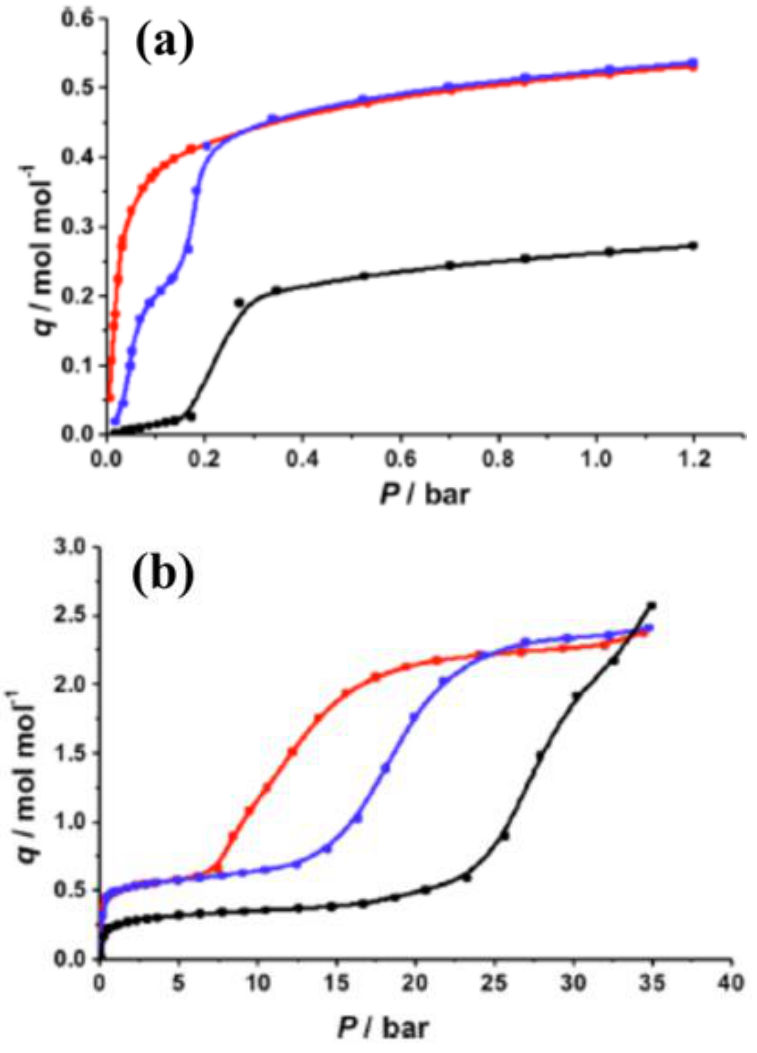
Figure 32. CO adsorption isotherms at 273 K. ( a ) 120 kPa; ( b ) 3.5 MPa. Red: 2 NH -MIL-53(Al); Blue: NH -MIL-53(Ga); Black: NH 2 2 permission from [147]. Copyright 2012 American Chemical